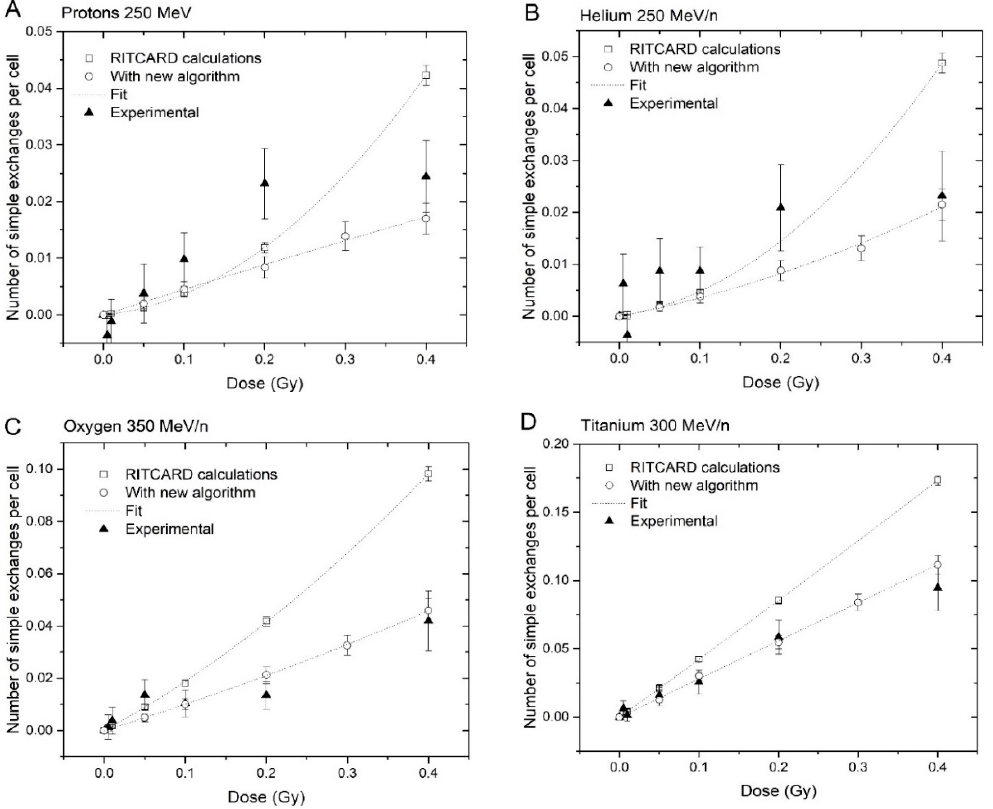
Figure 8. Comparison of RITCARD results obtained using the old and the new restitution algorithms, and experimental data for ( A ) protons 250 MeV, ( B ) helium 250 MeV/n, ( C ) oxygen 350 MeV/n, and ( D ) titanium 300 MeV/n.